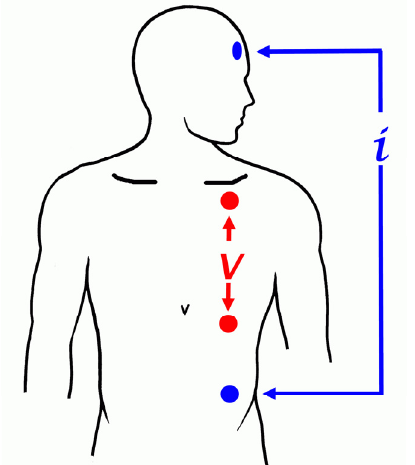
Fig.1: Electrode configuration. A small alternating electrical current of 0.3 mA r.m.s. and 64 kHz was applied to the thorax by means of the two outer electrodes. The two inner electrodes measured the subsequent electrical voltage difference over the heart. From the time course of this voltage signal the impedance signal was